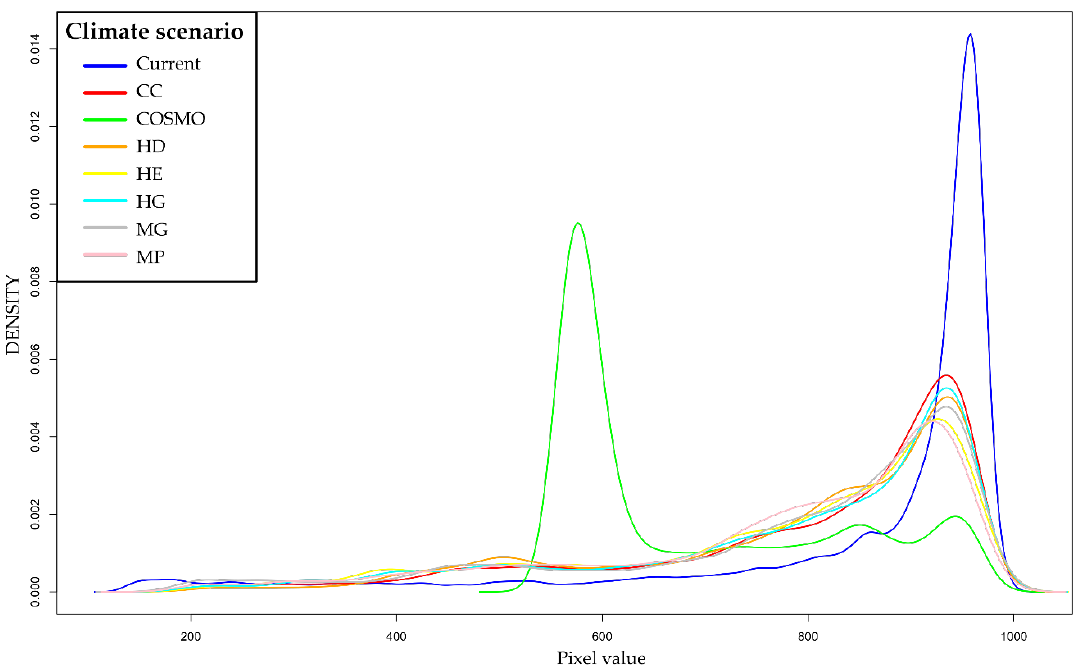
Figure 3. Density distribution (histogram) of each “maximum GCMs and RCM” obtained in this study when using the maximum land suitability value for each pixel within the 19 analyzed species.